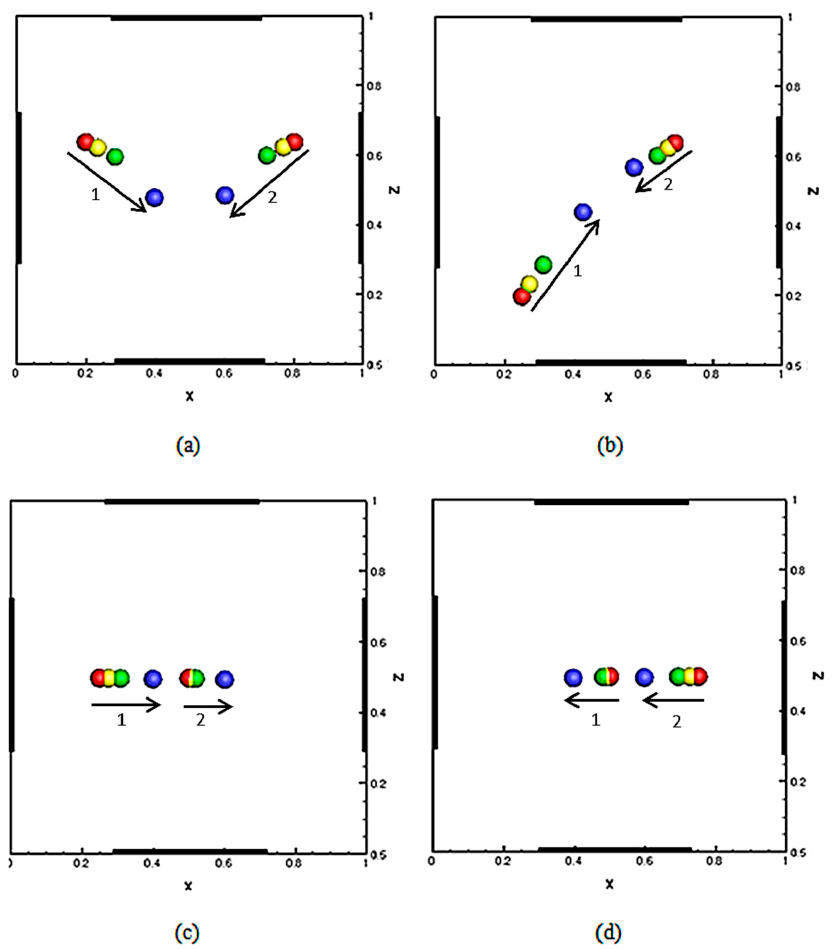
Figure 7. The DEP force-induced motion of two particles in the xz -plane under negative dielectrophoresis. The diameter of particles is 0.1. The initial positions of the particles, shown by red circles, are: ( a ) (0.2, 0.25, 0.65) and (0.8, 0.25, 0.65); ( b ) (0.25, 0.25, 0.2) and (0.5, 0.25, 0.65); ( c ) (0.25, 0.25, 0.50) and (0.5, 0.25, 0.50; ( d ) (0.75, 0.25, 0.50) and (0.50, 0.25, 0.50). The dimensionless parameters are: Re = 0.0562, P E = 1670, and P 4 =